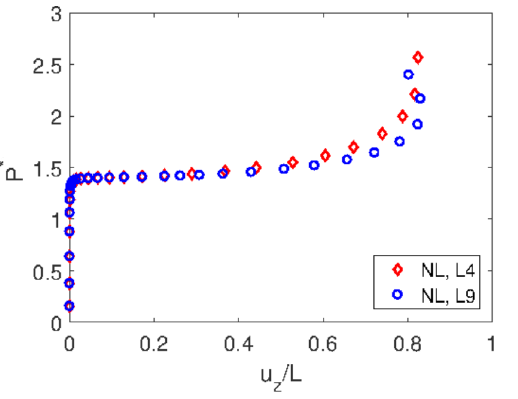
Figure 6. The equilibrium curves for L4 and L9 of the single-cell composite beam subjected to axial loading, P* = 4 PL 2 / π 2 EI